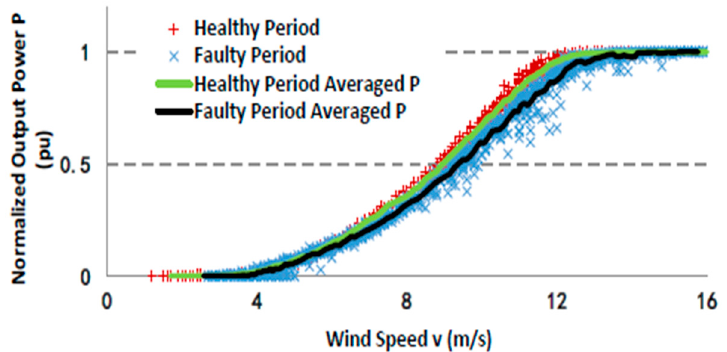
Figure 9. Power curve of a WT in health and fault.